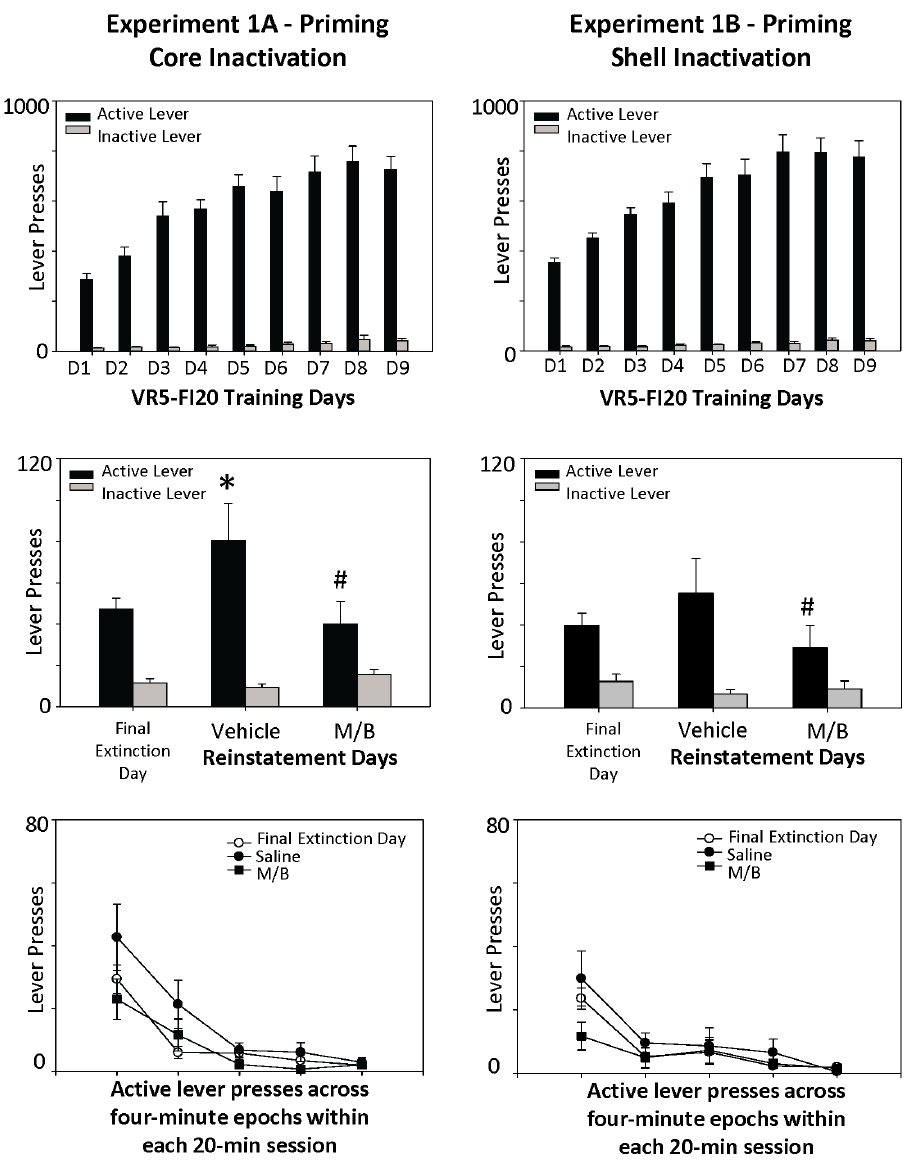
Figure 2. Effects of NAcc core and shell inactivation on priming-induced reinstatement. Top panels demonstrate that rats were showing robust lever-pressing on the VR-5, FI-20 schedule by the completion of training (top panels). The middle panels demonstrate a significant effect of NAcc inactivation on priming-induced reinstatement on the previously active lever, regardless of whether the muscimol/baclofen cocktail was injected into the core or the medial shell. There were no changes in pressing on the inactive lever across extinction and reinstatement test conditions. Bottom panels represent the pattern of lever pressing across the reinstatement period and suggest that drug treatment blocked reinstatement early in the session, which then extinguished across time during all test days. Stars (*) on the bar graphs indicate a significant increase in lever pressing on the saline reinstatement day; number signs ( # ) indicate a significant decrease in lever pressing activity as compared to that observed on the saline reinstatement day (as determined by Tukey’s HSD).